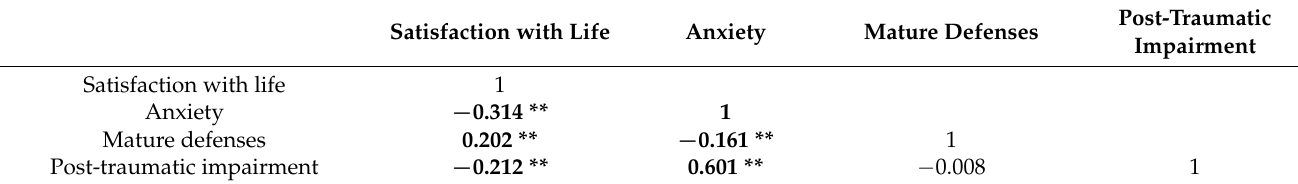
Table 1. Zero-order Pearson’s correlation